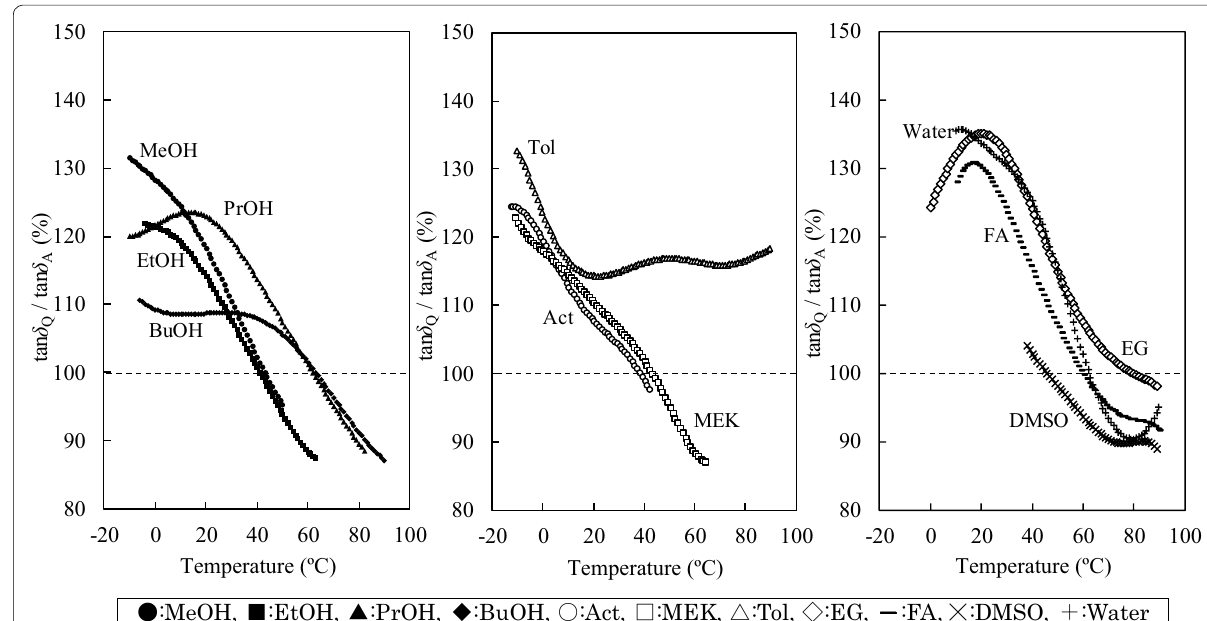
Fig. 4 tan δ Q /tan δ A of untreated samples swollen by water or each organic liquid. The tan δ Q is the tan δ measured after quenching. The tan δ A is the tan δ measured after annealing